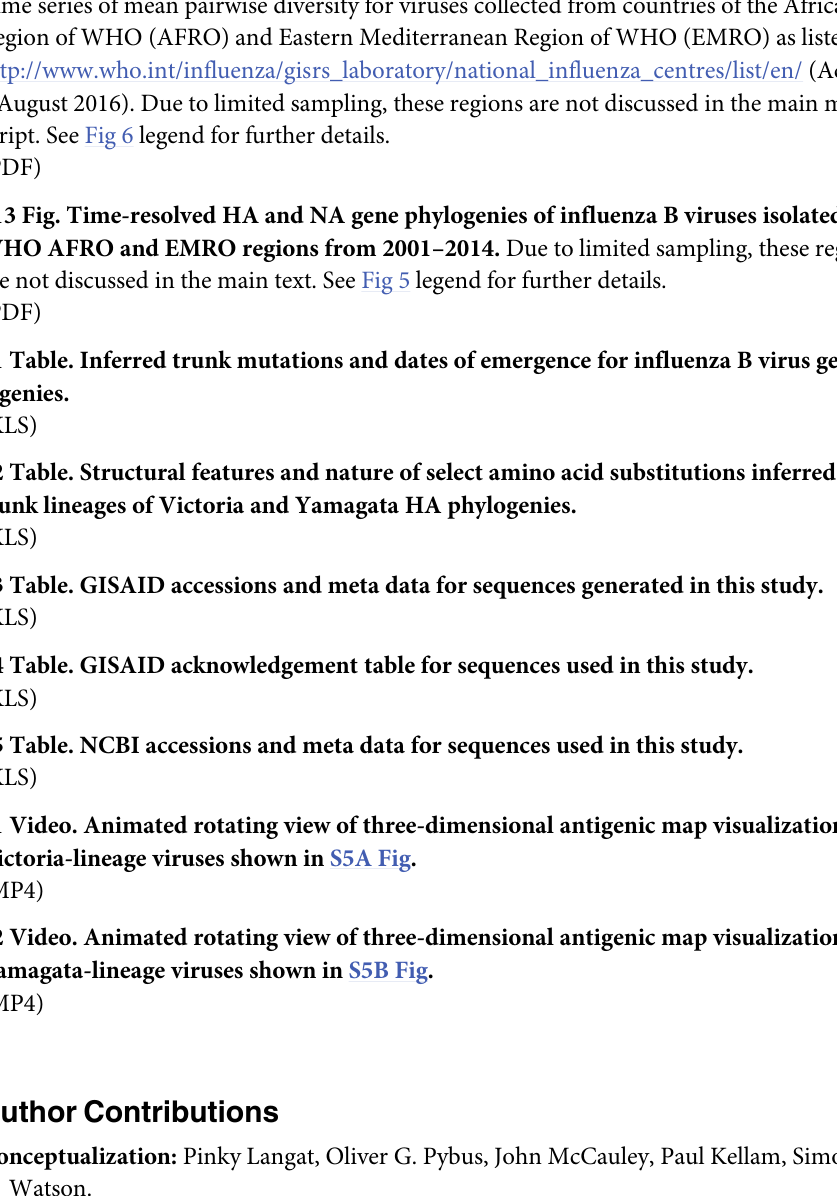
S12 Fig. Genetic diversity of gene segments over time in less-sampled geographic regions. Time series of mean pairwise diversity for viruses collected from countries of the African Region of WHO (AFRO) and Eastern Mediterranean Region of WHO (EMRO) as listed on